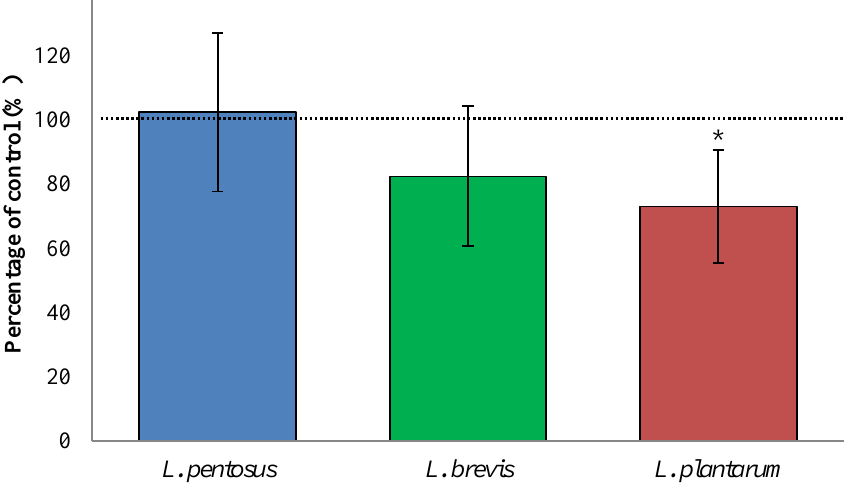
Figure 2. TG2-mediated transamidation of in vitro digested, fermented and unfermented, wheat flour in the presence of a primary amine indicates the interaction of TG2 and various binding sites on gluten protein. The change in transamidation caused by lactic fermentation was 73%–102% of the control. Data are presented as means ± SD ( n = 27–32). The asterisk indicates a significant change ( p < 0.05) from